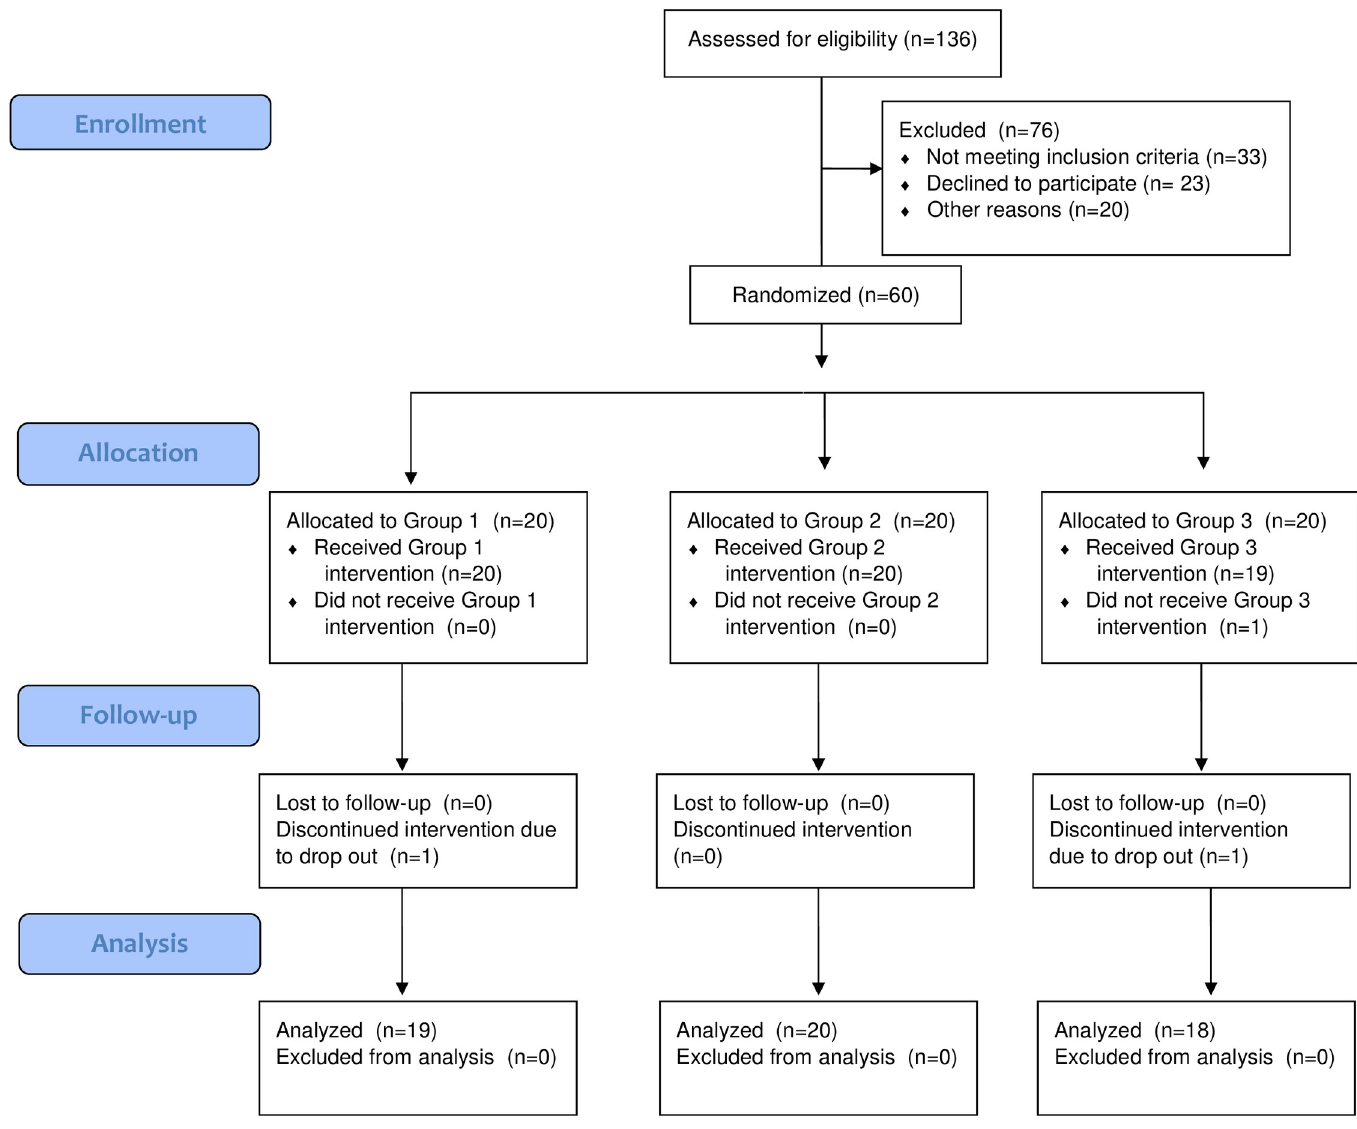
Fig 1. CONSORT flow